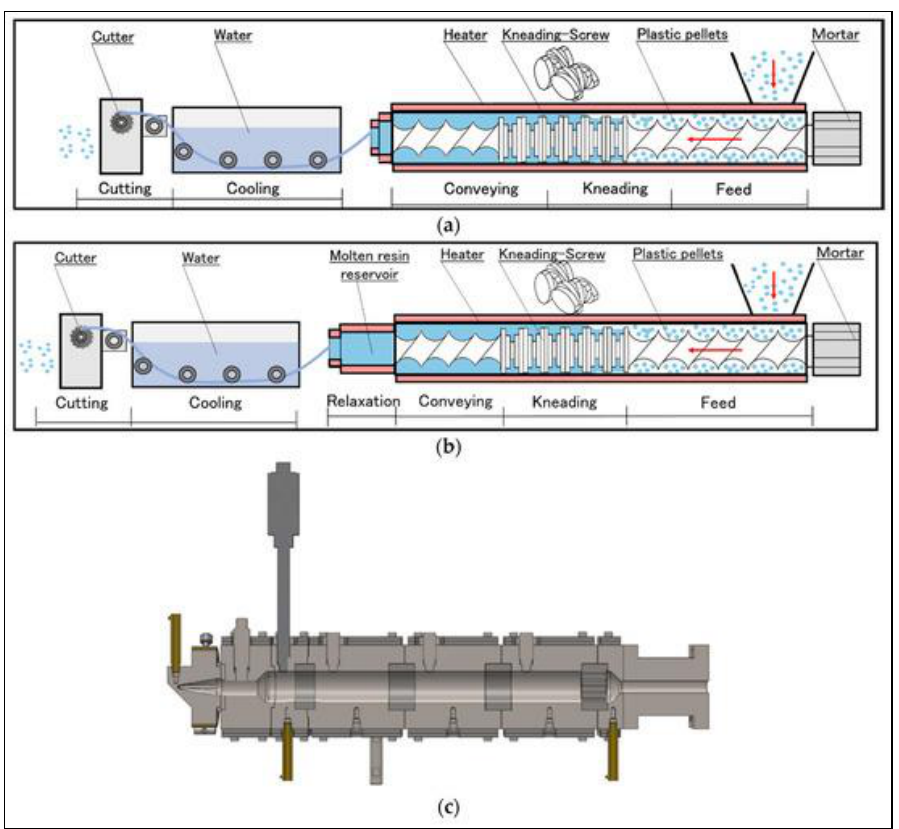
Figure 3. Schematic of the screw extruder ( a ) without and ( b ) with the molten resin reservoir, and ( c ) cross-sectional schematic of the molten resin reservoir. Reproduced from ref [34].